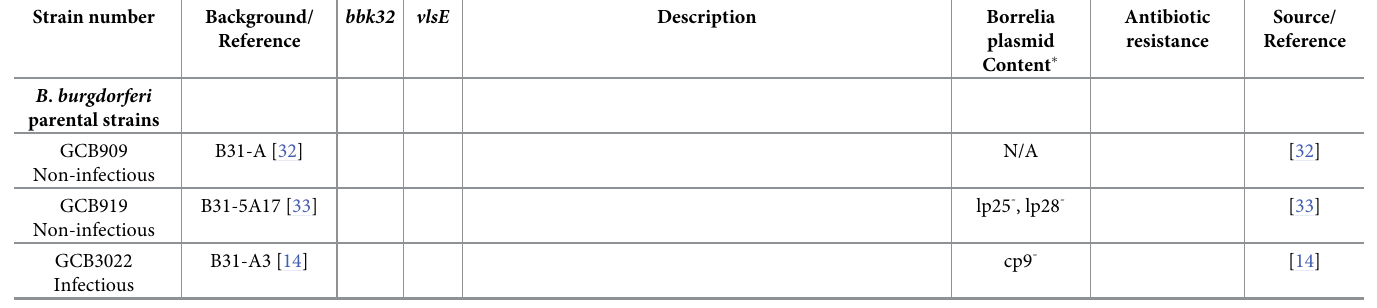
Table 1. Bacterial strains